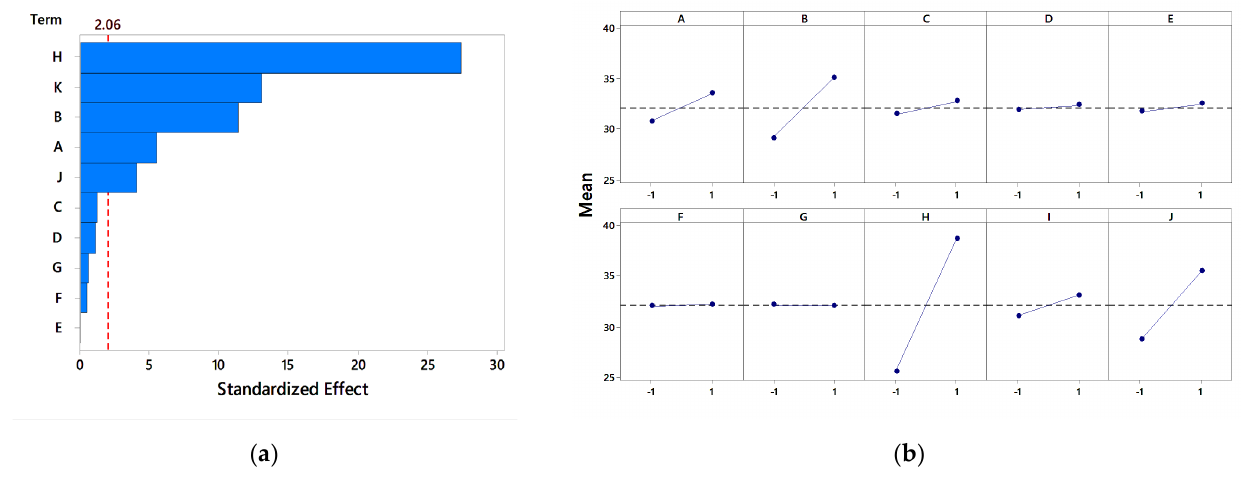
Figure 6. Analysis of the PB design for nitrogen sources ( a ) Pareto chart, ( b ) main effect plot. In the Pareto chart analysis, peptone, soya peptone, beef extract, and yeast extract were observed to be significant, with peptone as the most significant nitrogen source at a 95% confidence level, as shown in Figure 6a. Thus, peptone was further selected for optimization studies using RSM and CCD. In the main effect plot, as shown in Figure 6b, the average response for peptone was highest and at a higher level compared to the other nitrogen sources. This indicated that peptone has a significant effect on pectinase activity. The main effect plot of Na 2 NO 3 , (NH 4 ) 2 SO 4 , ammonium nitrate, ammonium acetate,